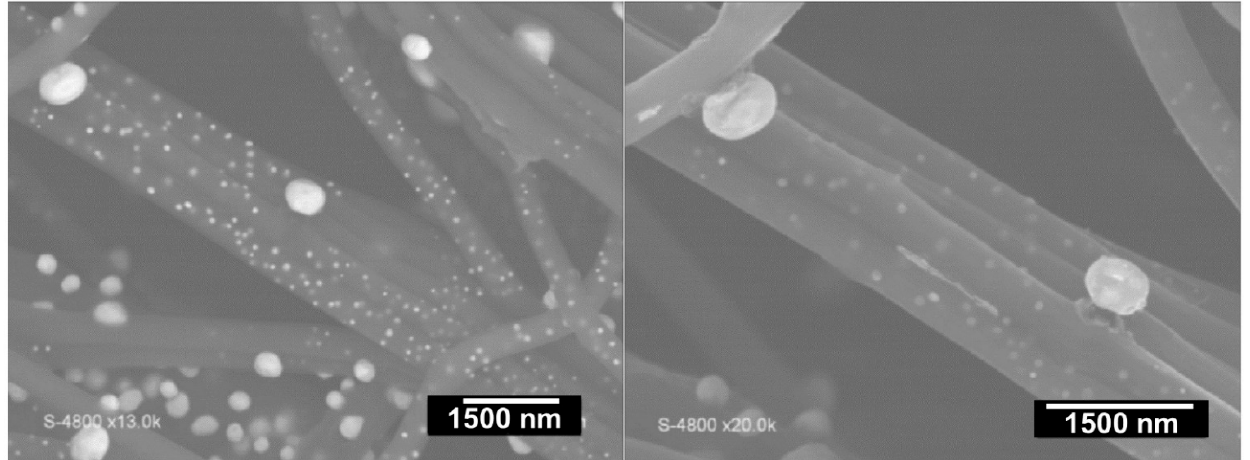
Figure 7. SEM images of Au@CFs at different magnifications after stabilization under air (2 °C min − 1 until 250 °C for 2 h stay) and calcination under high-purity nitrogen atmosphere (2 °C min − 1 until 1000 °C for 10 h stay). Reprinted and adapted with permission from ref. [34]; Copyrights 2016, Wiley-VCH Verlag GmbH and Co. KGaA, Weinheim.